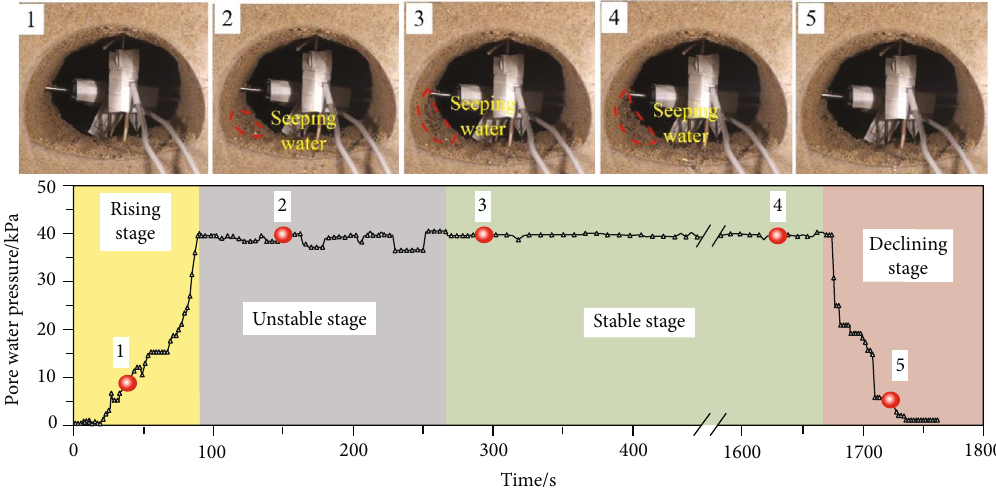
Figure 4: Actual curve of pore water pressure in a water pressure loading process ( d = 80mm , N = 11 ).